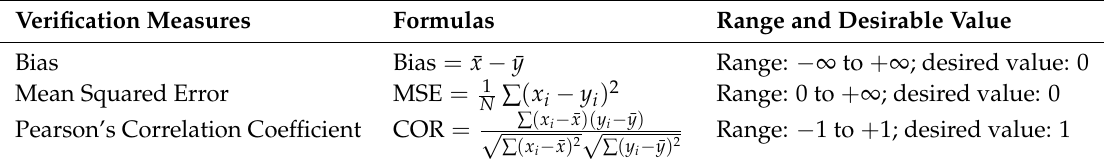
Table 4. Common verification measures for the satellite-based precipitation estimation